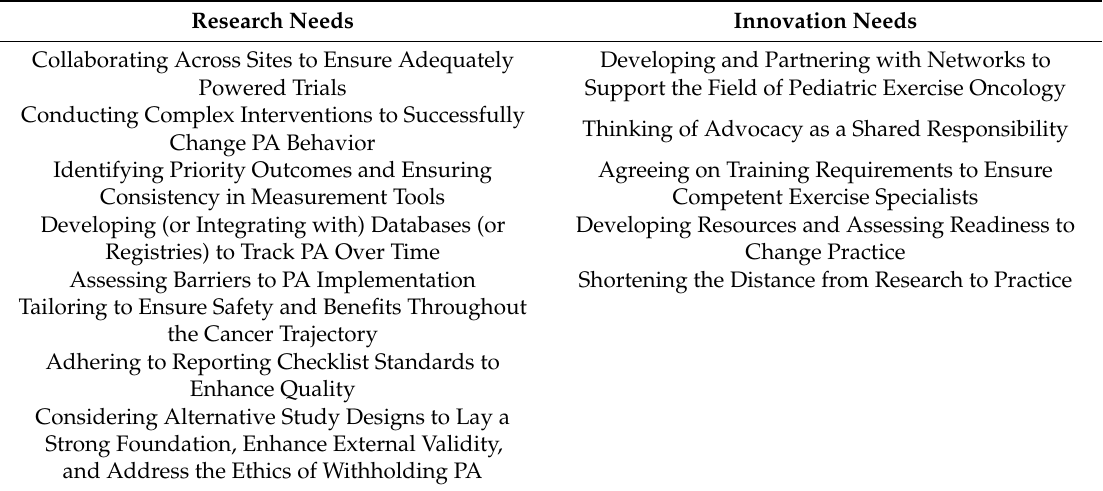
Table 1. Research and innovation